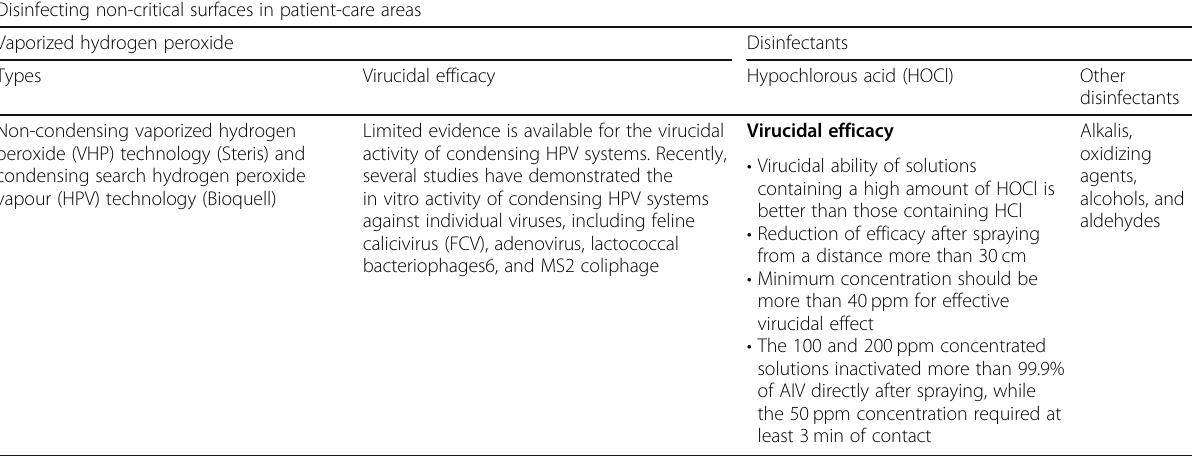
Table 3 Methods of disinfecting non-critical surfaces in patient-care areas Disinfecting non-critical surfaces in patient-care areas Vaporized hydrogen